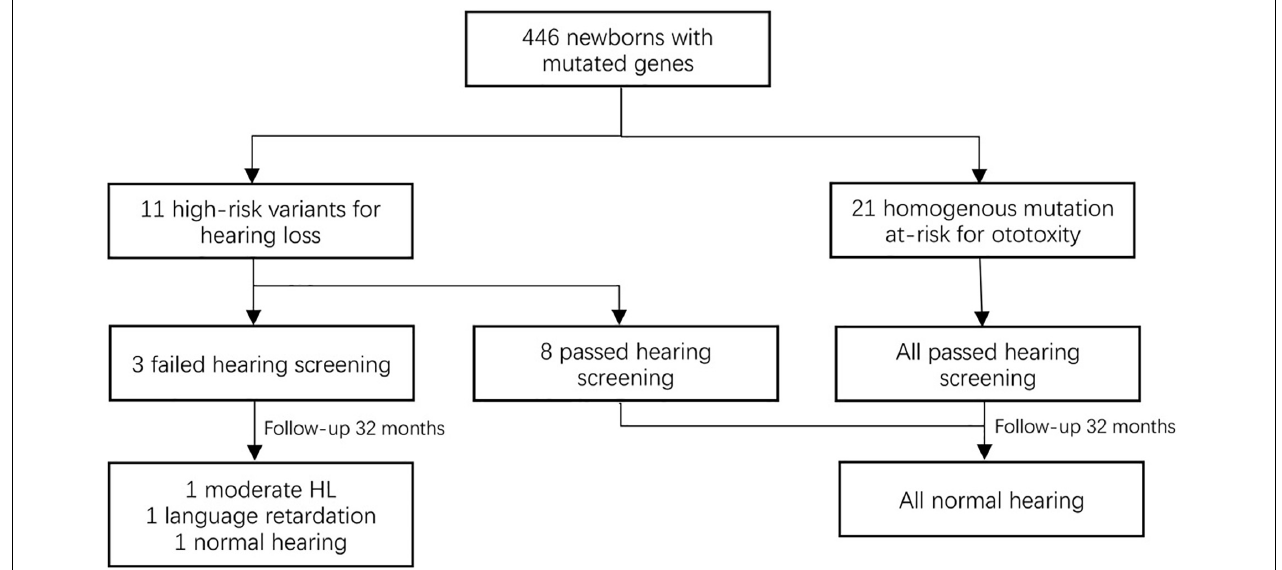
FIGURE 2 | The hearing outcomes of newborns with positive